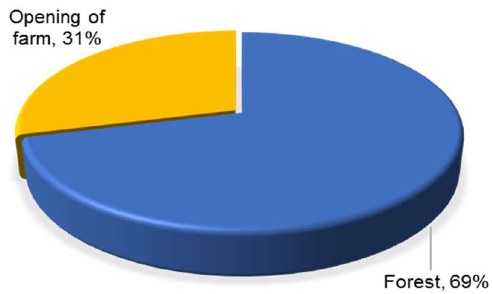
Figure 5. Source of wood for barn construction in Mwazisi ( n = 181).